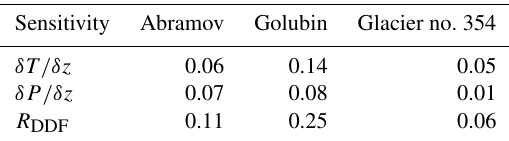
Figure 6. Comparison between the annual SMB obtained from the TSL-constrained model when using meteorological and climatolog- ical average daily data for Abramov, Golubin and Glacier no. 354. Table 5. Model sensitivity to the different constant input parameters for each glacier in mw.e.yr − 1 . See text for details on the experi-